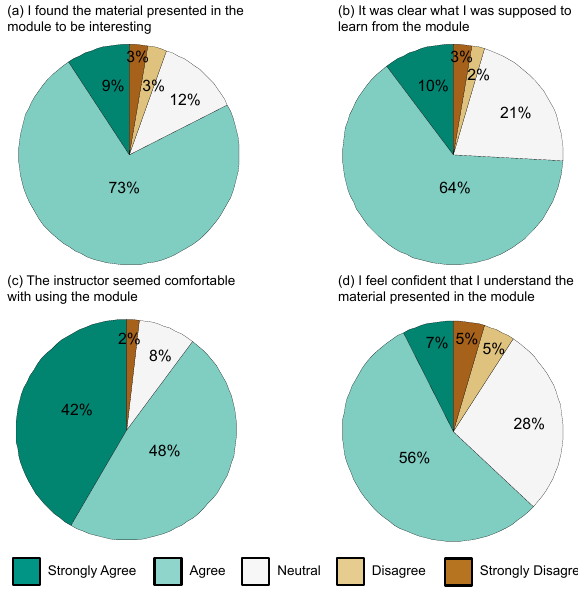
Fig. 4. Student responses from the initial MOCHA module assess- ment at Plymouth State (5 students), Montana State (27 students), and Penn State (78